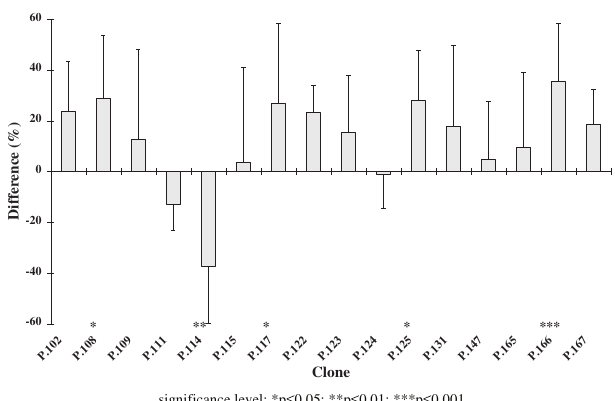
Figure 5. Divergences of ‘Kadarka’ clones in the average mass of the cluster from the P. 9 clone (Szekszárd - Batti field, 2011)